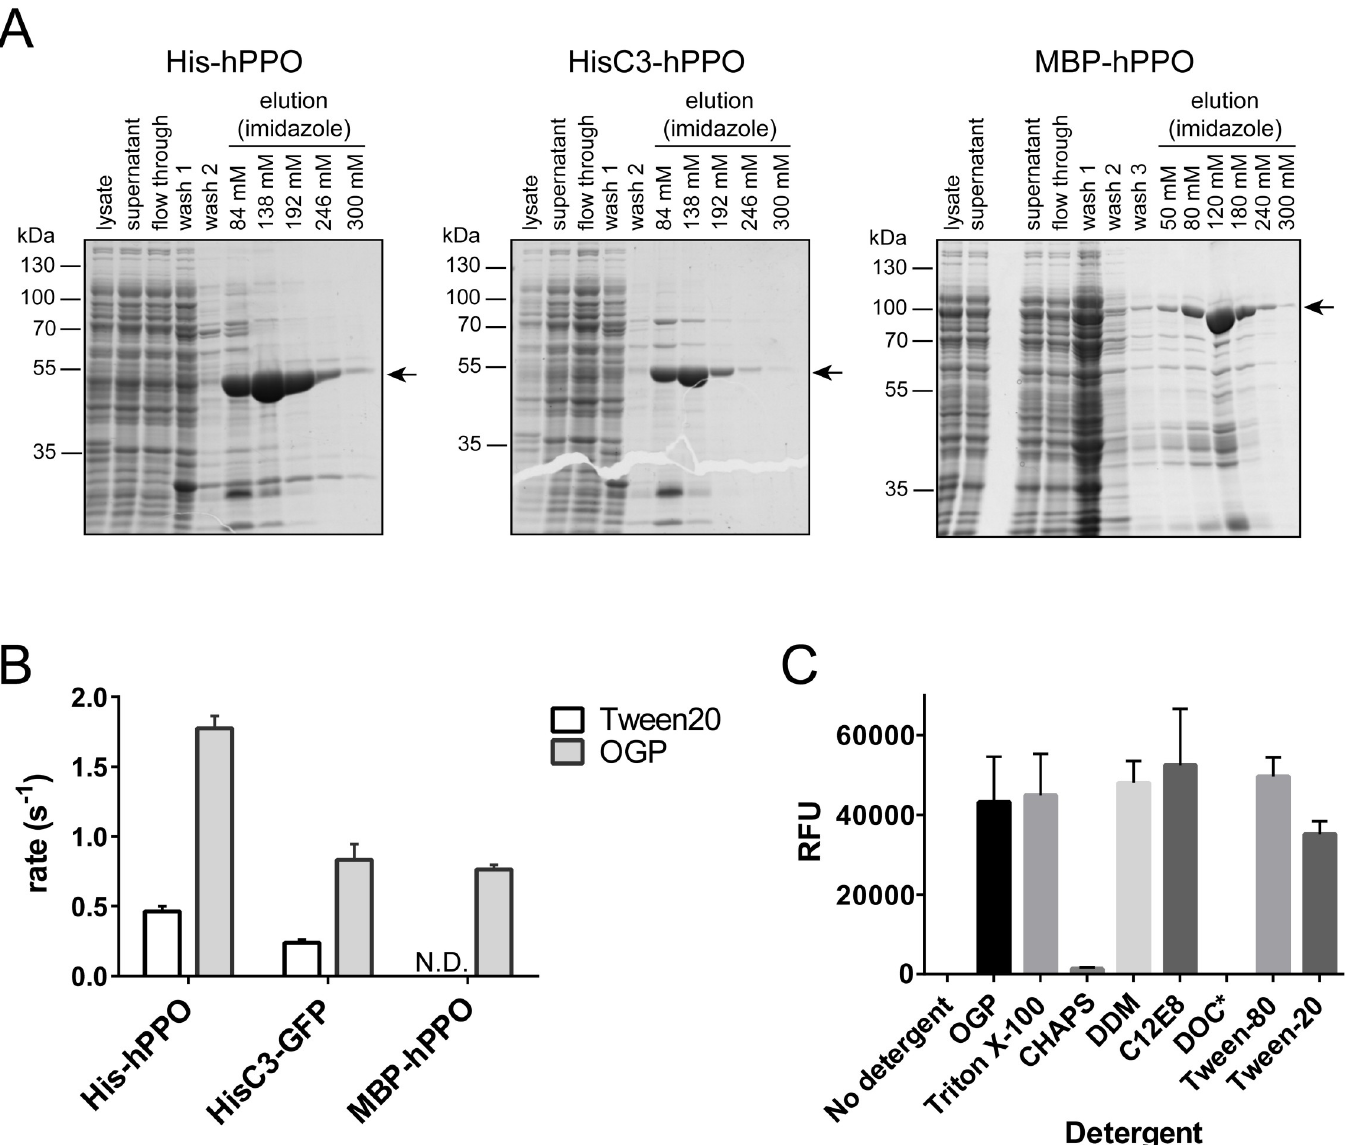
Fig 2. Prokaryotic hPPO expression, purification, and enzymatic activity. A; Coomassie-stained SDS-PAGE of hPPO variants purified by Ni-NTA affinity chromatography. Position of constructs marked by arrows. B; Substrate conversion rates of E . coli -expressed hPPO variants using protoporphyrinogen IX as a substrate (N.D., not determined). C; Specific activity of hPPO in the presence of various detergents estimated via conversion of protoporphyrinogen IX.